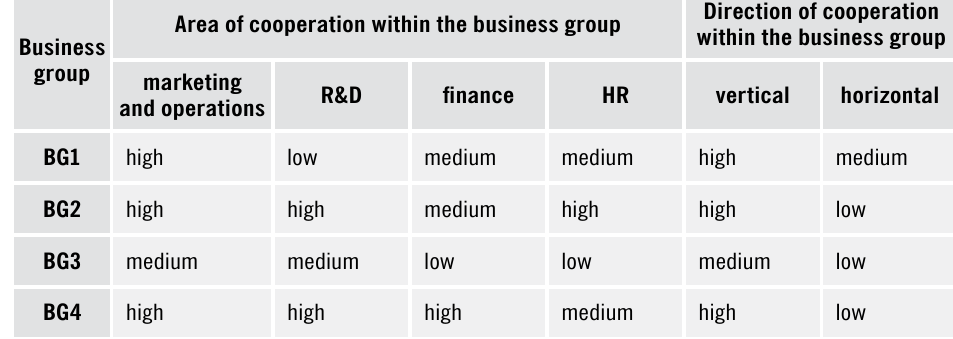
Direction of cooperation within the business